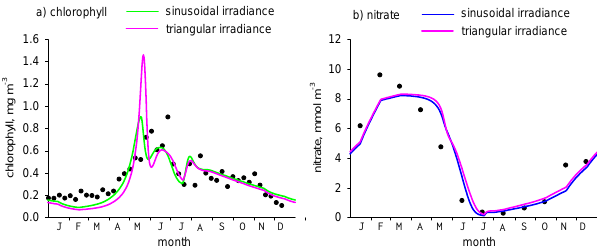
Figure 17. Simulations for station BIOTRANS showing sensitiv- ity to choice of diel variation in irradiance: (a) sinusoidal (standard run), (b) triangular.